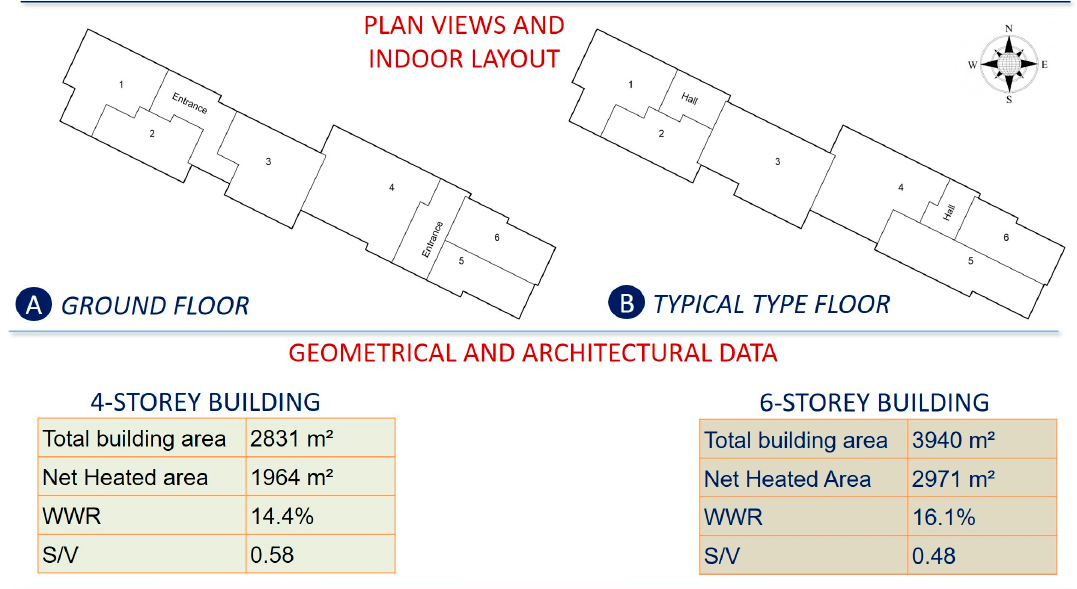
Figure 2. Reference building: ( a ) floor distribution; ( b ) geometrical